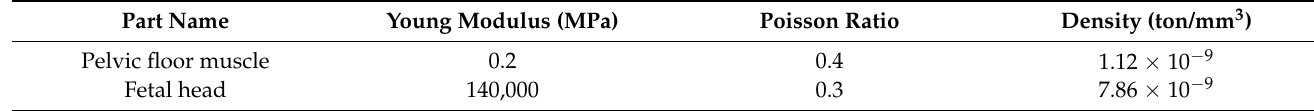
Table 2. Material parameter list.